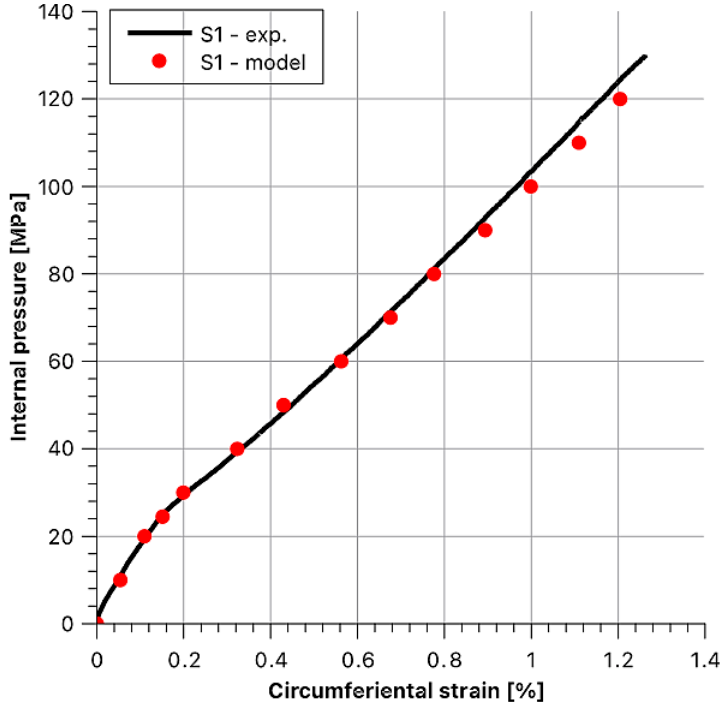
Figure 20. Stress and strain results as a function of internal pressure for sample S1.